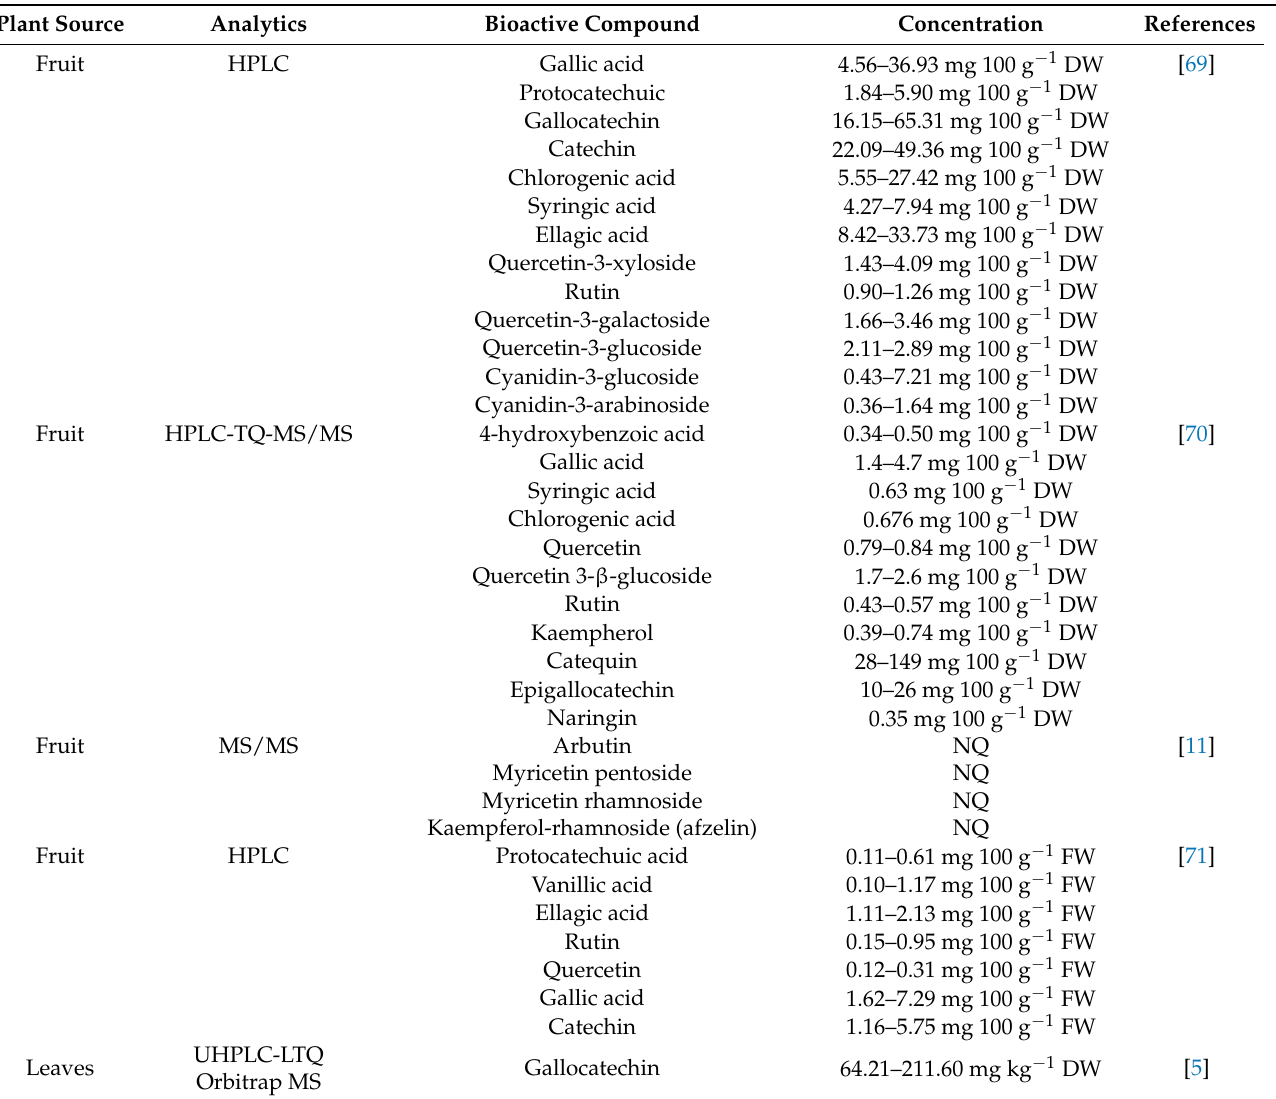
Table 1. Individual bioactive compounds found in A. unedo fruits and